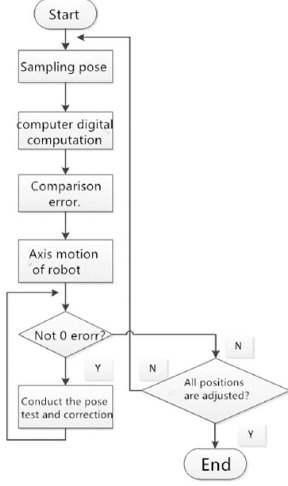
Figure 3. Control flow